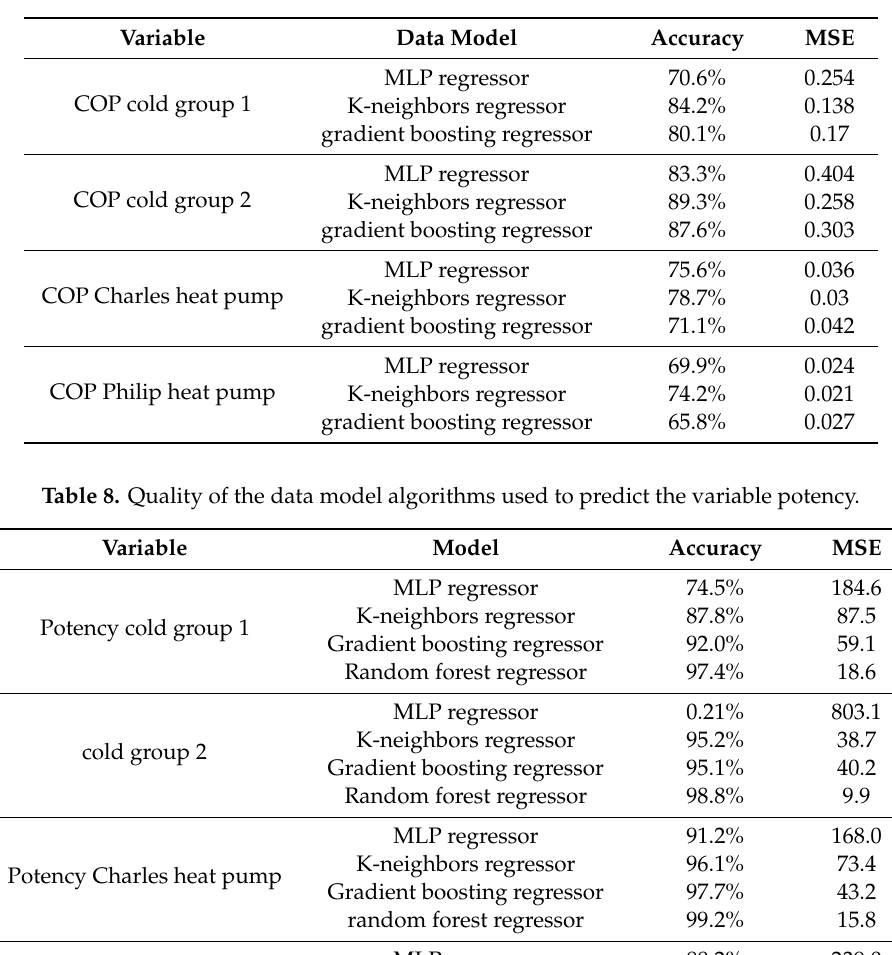
Table 7. Quality of the algorithms used to predict the variable COP.